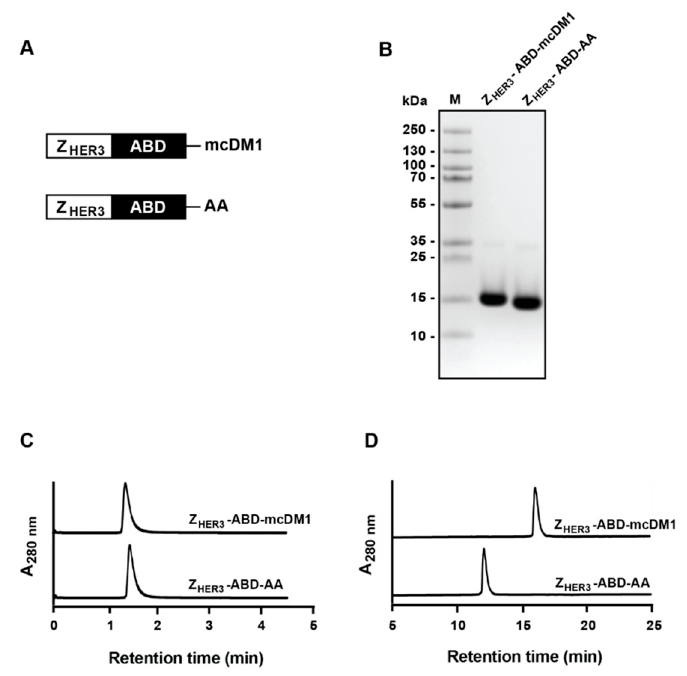
Figure 1. Schematic description and biochemical characterization of the drug conjugate Z HER3 -ABD-mcDM1 and the non-toxic control Z HER3 -ABD-AA. ( A ) The schematic figure shows the two constructs, Z HER3 -ABD-mcDM1 and Z HER3 -ABD-AA. ( B ) Samples (10 µ g each) of the two constructs were analyzed by sodium dodecyl sulfate polyacrylamide gel electrophoresis (SDS-PAGE) under reducing conditions. Lane M corresponds to the electrophoretic separation of marker proteins, with the indicated molecular weights, 10 to 250 kDa, to the left of the gel. ( C ) Size-exclusion chromatography analysis of the two constructs. ( D ) RP-HPLC analysis of Z HER3 -ABD-mcDM1 and Z HER3 -ABD-AA. The constructs were eluted with a 25 min linear gradient from 30% to 60% acetonitrile in water supplemented with 0.1% trifluoroacetic acid.